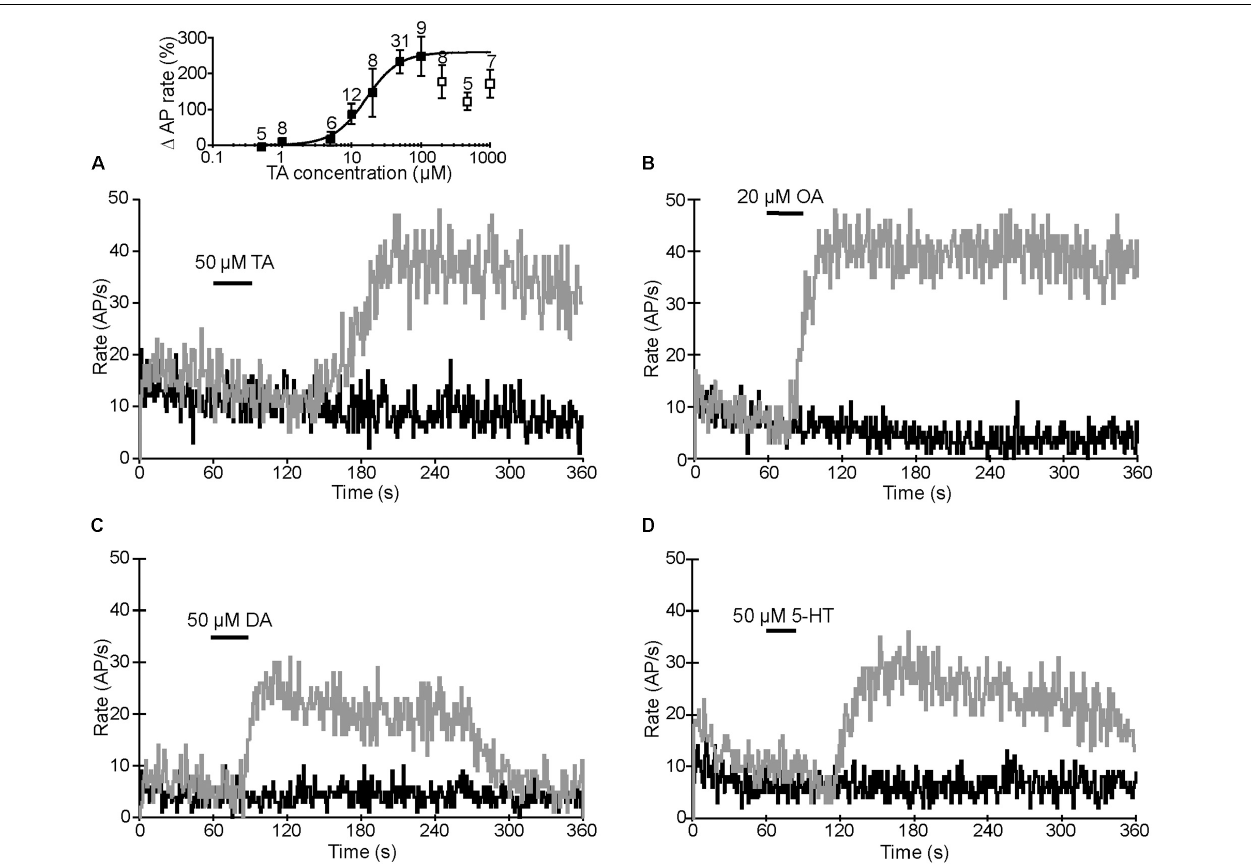
FIGURE 4 | Agonist effects on action potential (AP) rate. Black trace in each image is the AP rate in control recording when the preparation was superfused in normal spider saline. Gray traces are the AP rates recorded from the same neurons when TA (A) , OA (B) , DA (C) , or 5-HT (D) were applied at the times indicated. APs were elicited by pseudorandom white noise electrical stimulation and converted to AP rates. Inset in A: dose–response relationship for TA. Percentage changes in spike rates are plotted against TA concentrations. The data was fitted with the logistic Hill equation Y = Y max [C] n (cid:14) Y max [C] n (cid:0) [C] n [EC 50 ] n (cid:1)(cid:0) [C] n [EC 50 ] n (cid:1) , where Y is response, Y max is maximal response, [C] is agonist concentration, the half-maximal effective concentration [EC 50 ] is 16.3 µ M, and the Hill coefficient (n) is 1.8. The points used for the fit are shown as black squares. At concentrations above 100 µ M, the TA effect was below the peak value (white squares) and could not be fitted. Results are shown as means ± SE with the number of experiments indicated above each symbol.